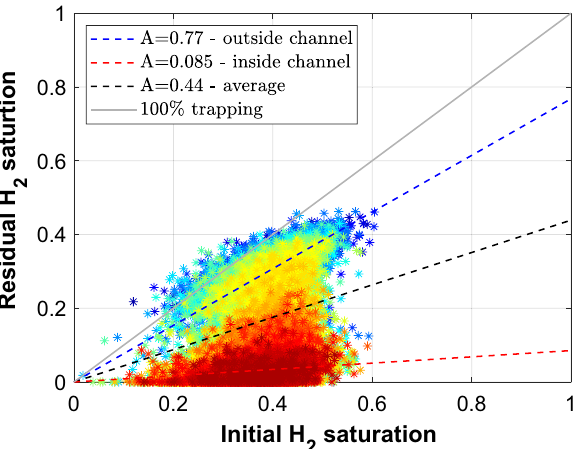
Figure 7. IR plot. Initial H 2 saturation at the start of Imbibition 2 versus the trapped H 2 saturation at the end of Imbibition 2. The colored stars are the voxel level H 2 saturation. The color correspond to vertical location in the core. Blue is at the top of the core and red is at the bottom of the core where the channel formed. The blue, black and red dashed lines are the best-fit linear trapping relationships for the top of the core (outside channel), the entire core, and the bottom of the core (inside channel), respectively. The grey line indicates the 100% trapping